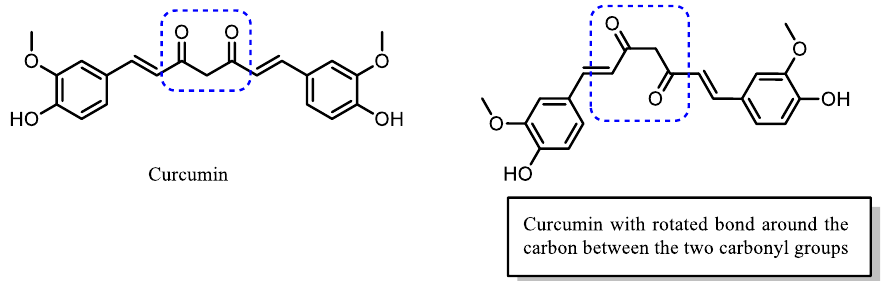
Figure 21. The structural flexibility of curcumin allows for bond rotation around the α -carbon, bridging the two carbonyl